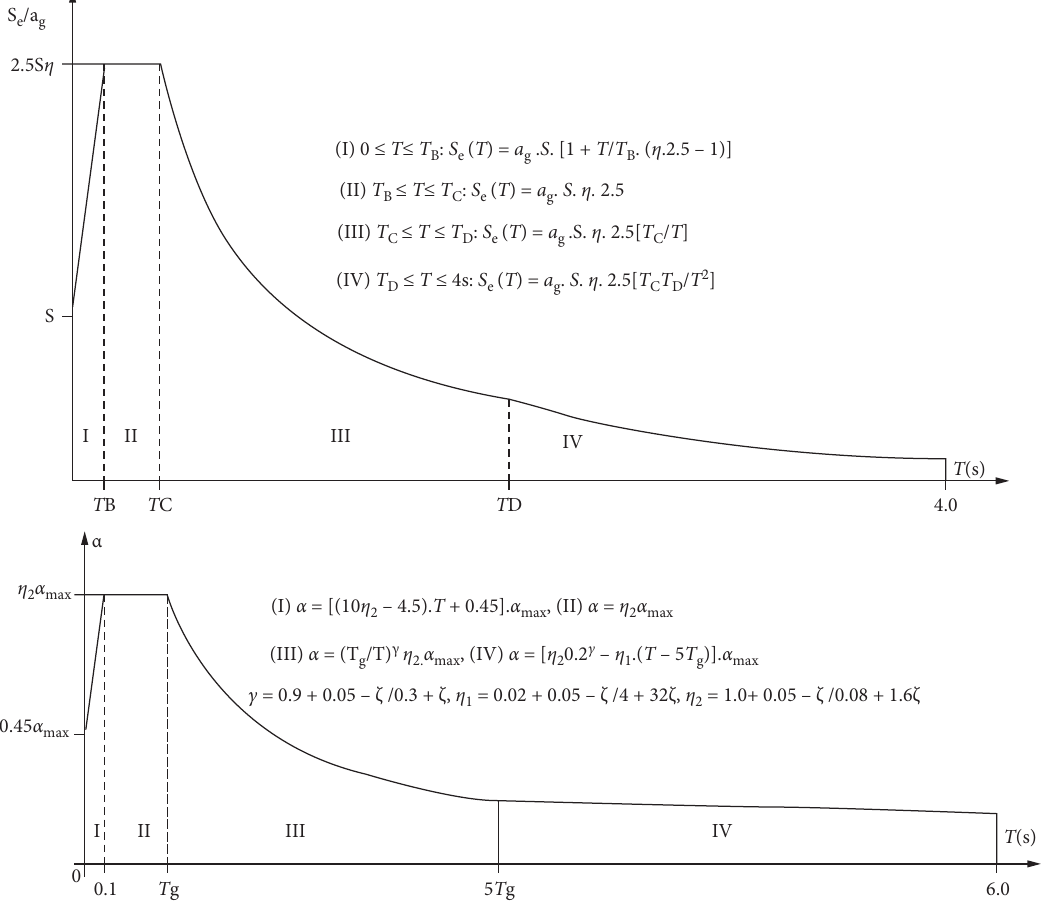
Figure 16: Design response spectrum provisions: (a) Ethiopia-ES8-15 and (b) Chinese